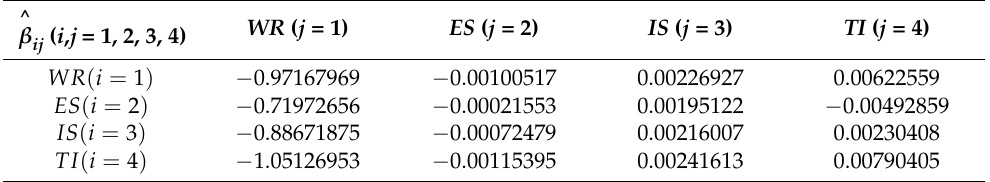
Table 11. GLV model related parameters of forecast data in Tianjin area.